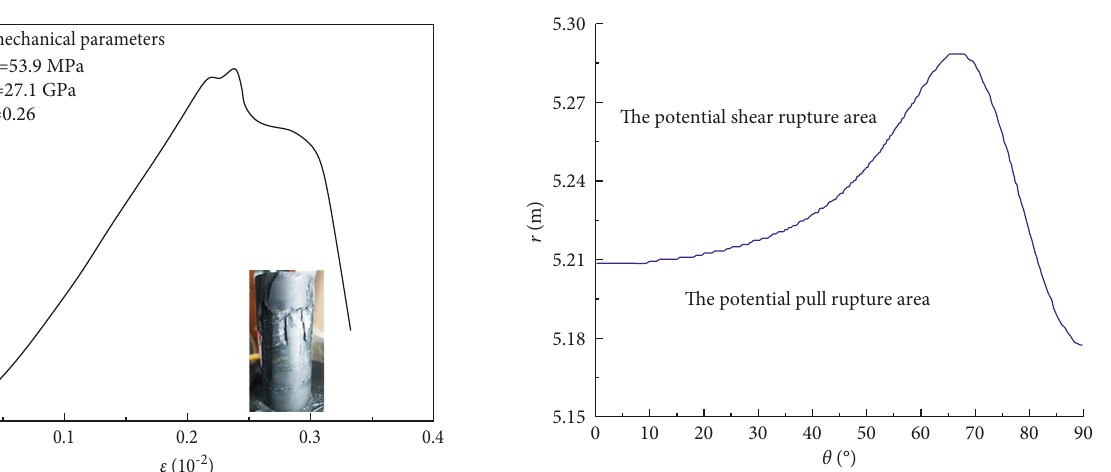
14: Uniaxial stress-strain curve ( E -Young’s modulus;